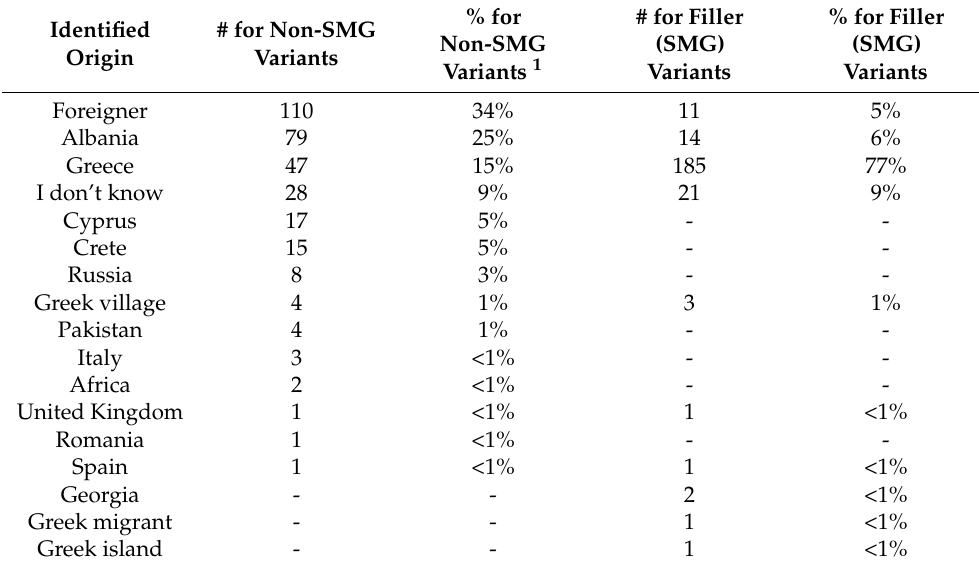
Table 2. Listener-identified talker origin.